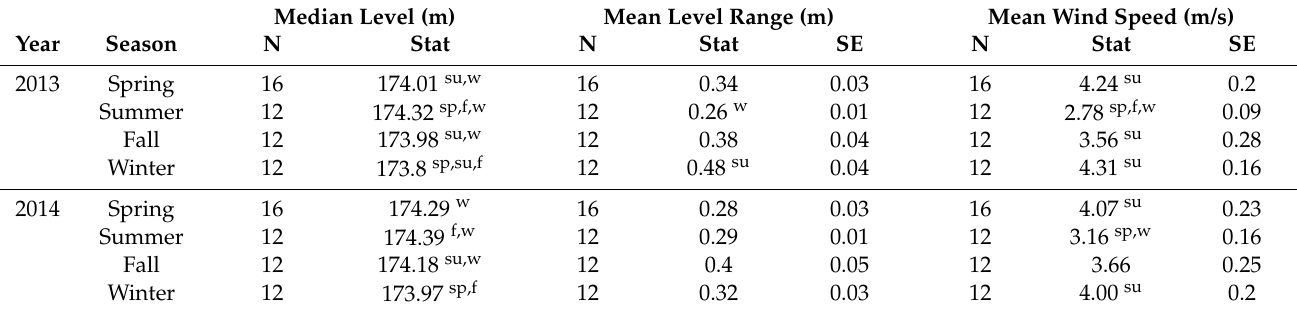
Table 2. Number of weeks sampled (n), mean weekly wind speed (m/s), median weekly Lake Erie water level, mean lake level range (m, above IGLD85) at Toledo OH., for the four seasons from 2013 and 2014. Superscripts indicate which seasons are significantly different from each other (sp is spring, su is summer, f is fall, and w is winter), within a year, one-way ANOVA ( p -value < 0.05) for range and wind speed and Kruskal–Wallis H-test ( p -value < 0.05) for median level. See text for date ranges of seasons. Data for wind speed and lake level were downloaded from http://tidesandcurrents.noaa. gov/ (Station no. 9063085) accessed 1 December